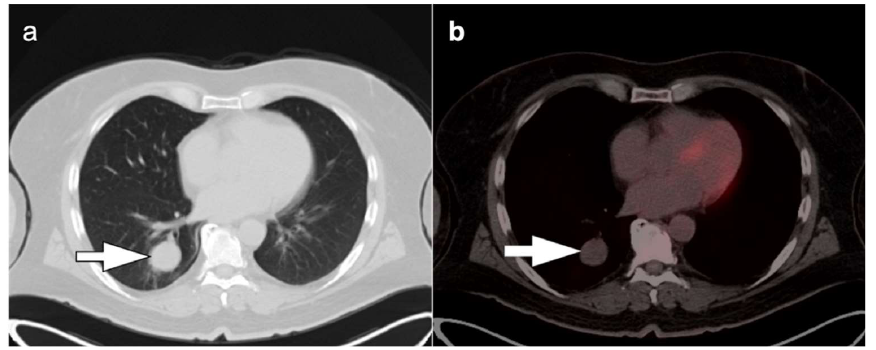
Figure 7. Bronchial carcinoid tumor. ( a ) Axial chest CT (lung windows) revealed a 3.0 cm, well- defined small mass with smooth margins in the right lower lobe ( white arrow ); ( b ) Corresponding FDG PET-CT showed minimal metabolic activity with an SUVmax of 1.2 ( white arrow ).